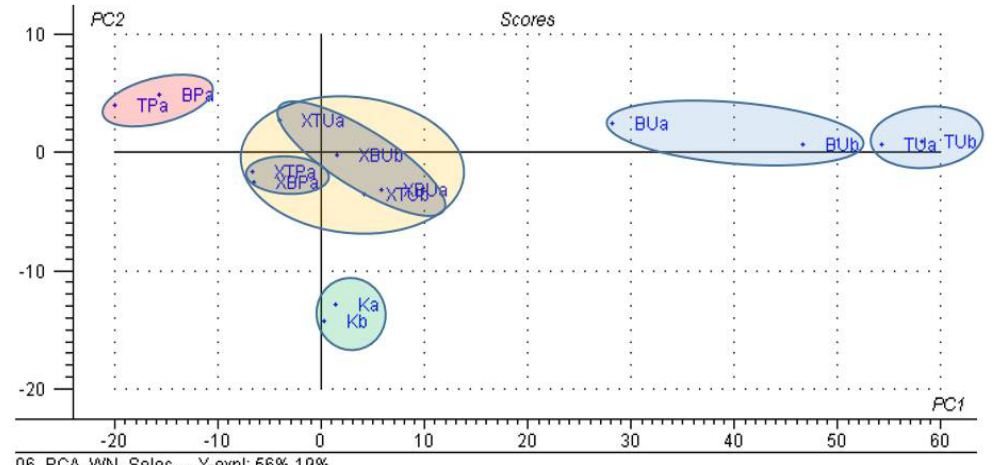
Figure 9. PC 2 versus PC 1 scores plot from the PCA analysis of the significant band wavenumbers from the FTIR data of the β-cyclodextrin/unprocessed and processed chicken breast and thigh lipid complexes (codes “XBU”, “XBP”, “XTU” and “XTP”), in comparison with β-cyclodextrin (code “K”) and non-complexed lipid fractions (codes “BU”, “BP”, “TU” and “TP”); “a” and “b” stand for duplicate samples.